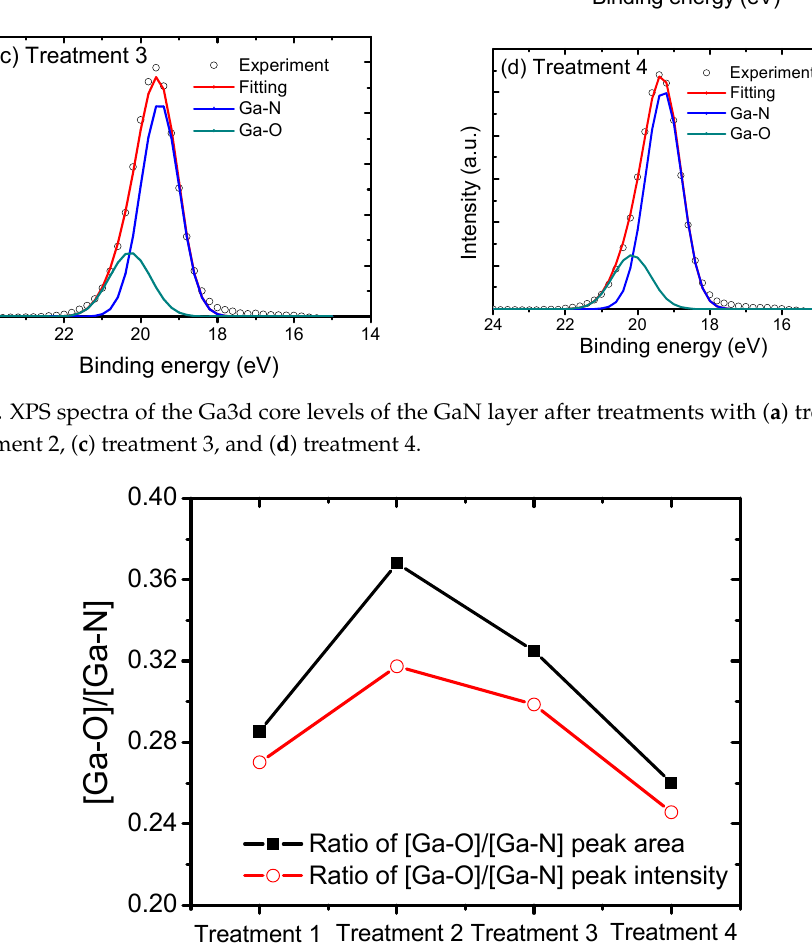
Figure 4. Ratio of Ga–O/Ga–N obtained using the XPS spectra from the Ga3d core levels of the GaN layer.